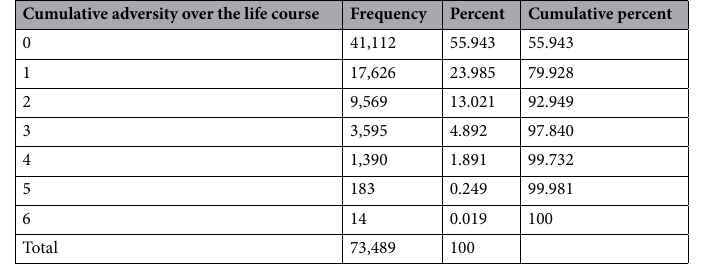
Table 1. Frequency table of the cumulative adversity over the life course.